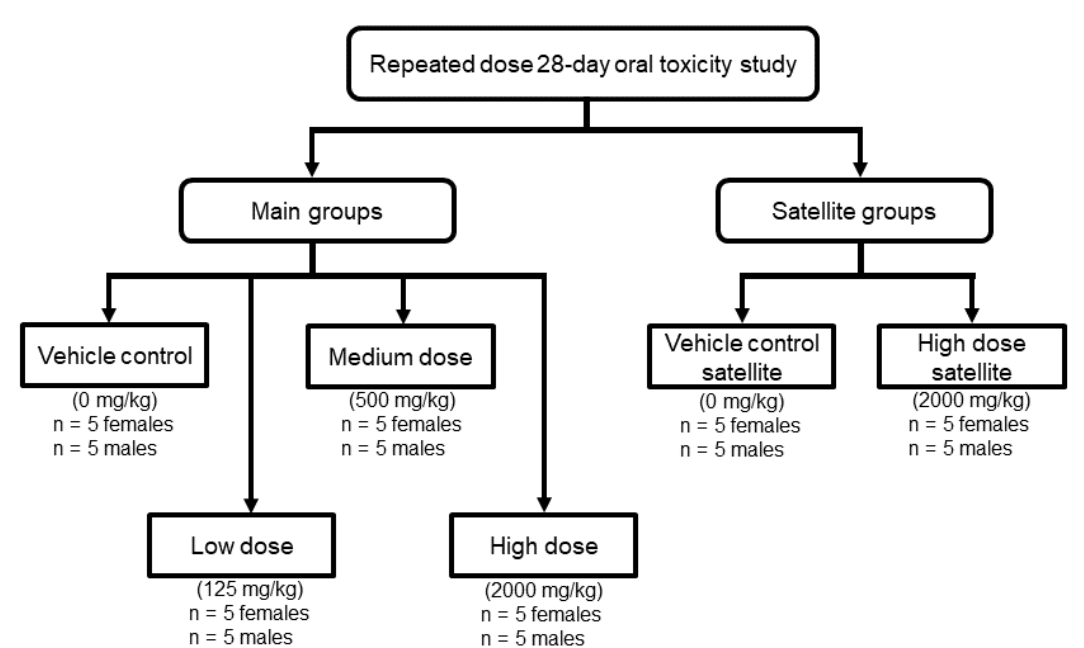
Figure 5. Study design for repeated dose 28-day oral toxicity study. Total number of rats involved was 30 females and 30 males.